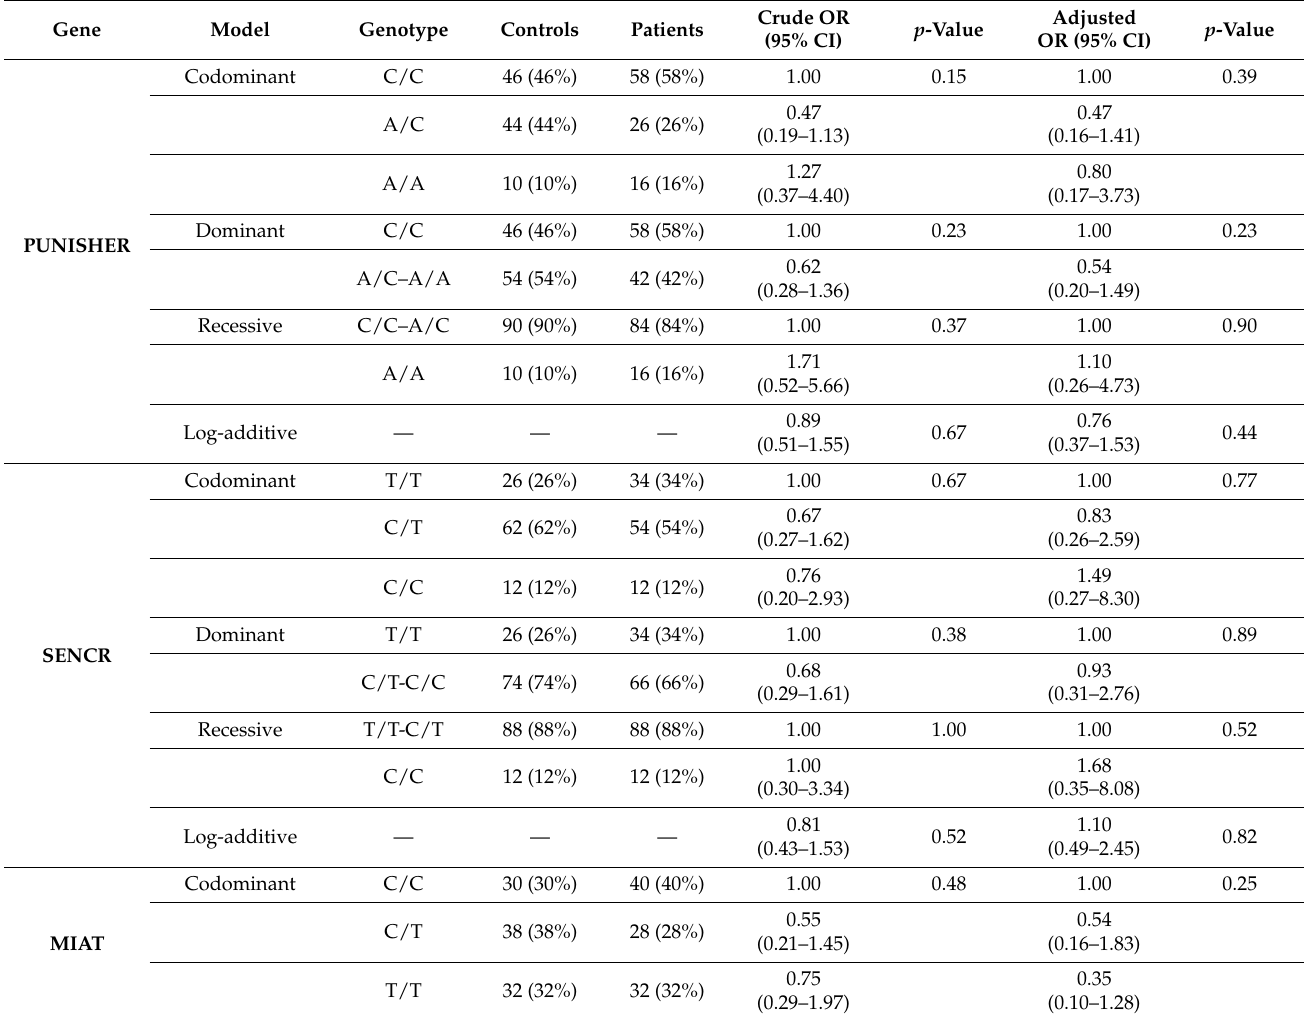
Figure 1. Minor allele frequency of the study lncRNA gene variants in the current study compared with 1000 Genomes Project Phase 3 (https://www.internationalgenome.org/) (last accessed 17 April 2021). AFR, Africa; AMR, America; EAS, East Asia; EUR, Europe; SAS, South Asia. Table 3. Genetic association models of lncRNA variants and disease risk.